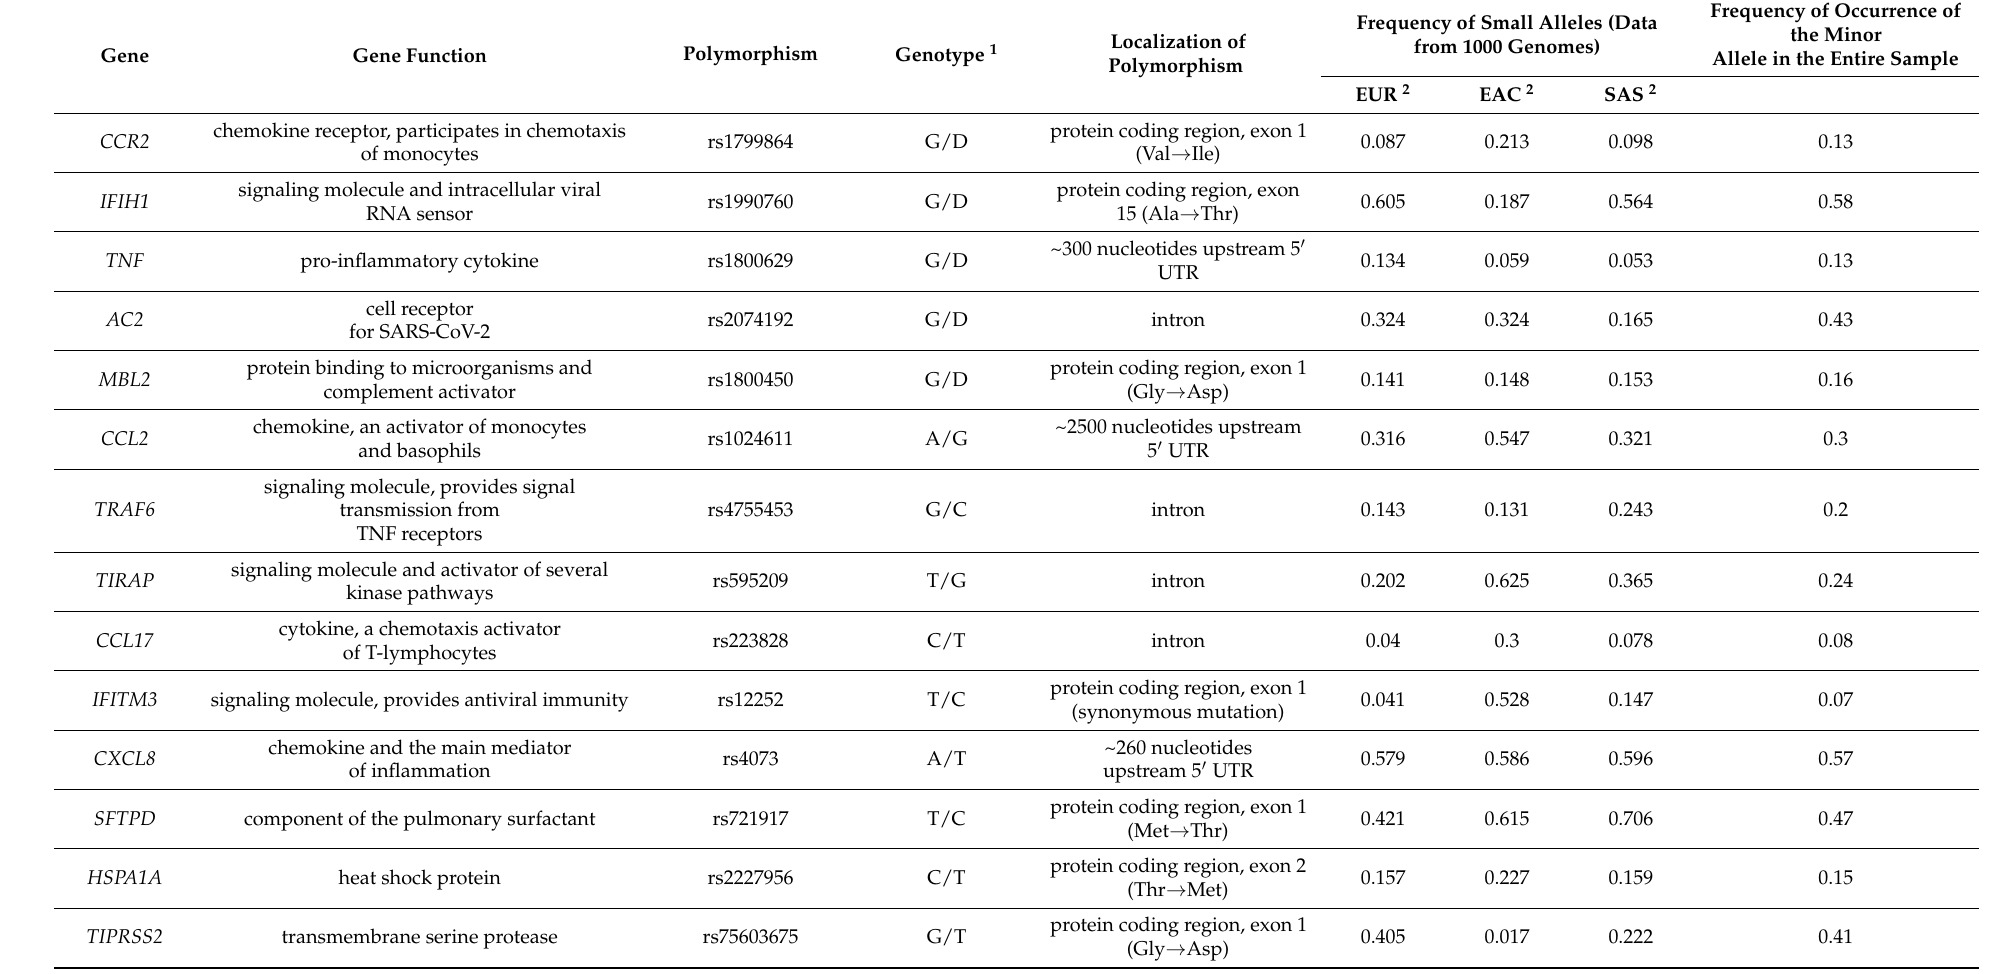
Table 3. Polymorphic markers, their localization, and frequency of